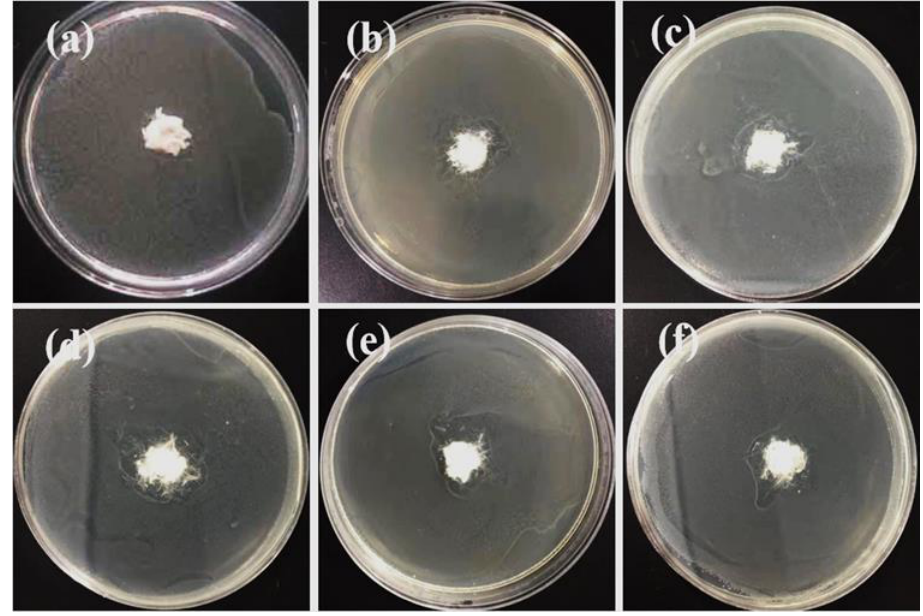
Figure 10. Antibacterial ( Staphylococcus aureus ) activity measurements of e-spun PP fibers containing ZnO: ( a ) 0 wt.%; ( b ) 1 wt.%; ( c ) 2 wt.%; ( d ) 3 wt.%; ( e ) 4 wt.%; ( f ) 5 wt.%. The diameter of all containers was 9 cm.